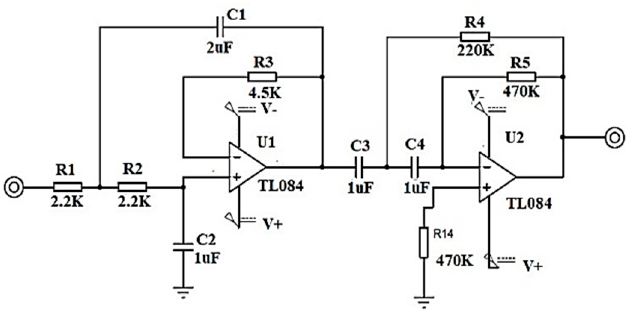
Figure 5. Filter in second order Butterworth configuration at 40 dB/decade.